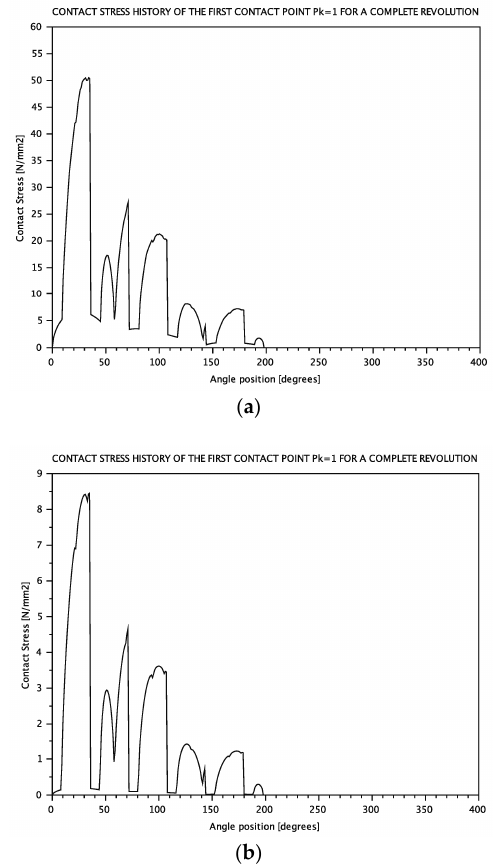
Figure 13. Contact stress history of the first contact point (P k1 in Figure 1) for a complete revolution of the outer gear [29] ( a ) sintered metal inner gear; ( b ) POM inner